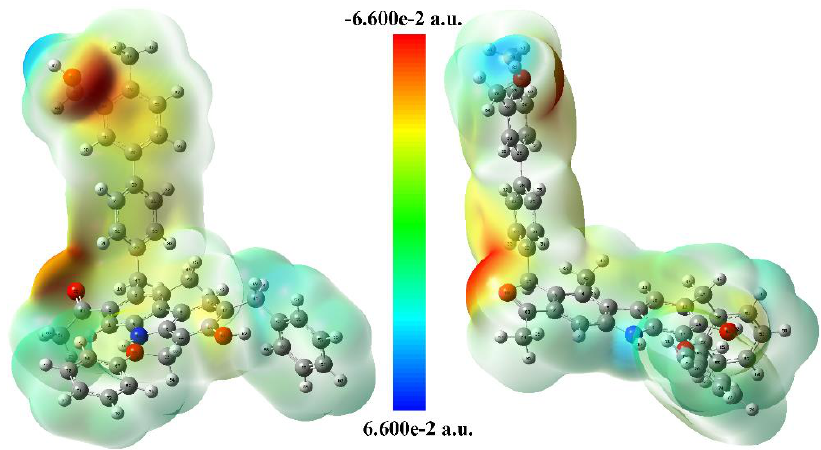
Figure 7. Front view (left) and side view (right) of electronic static potential (ESP). Table 2. Negative potential distribution on the surface of coal molecules. No. Site Potential